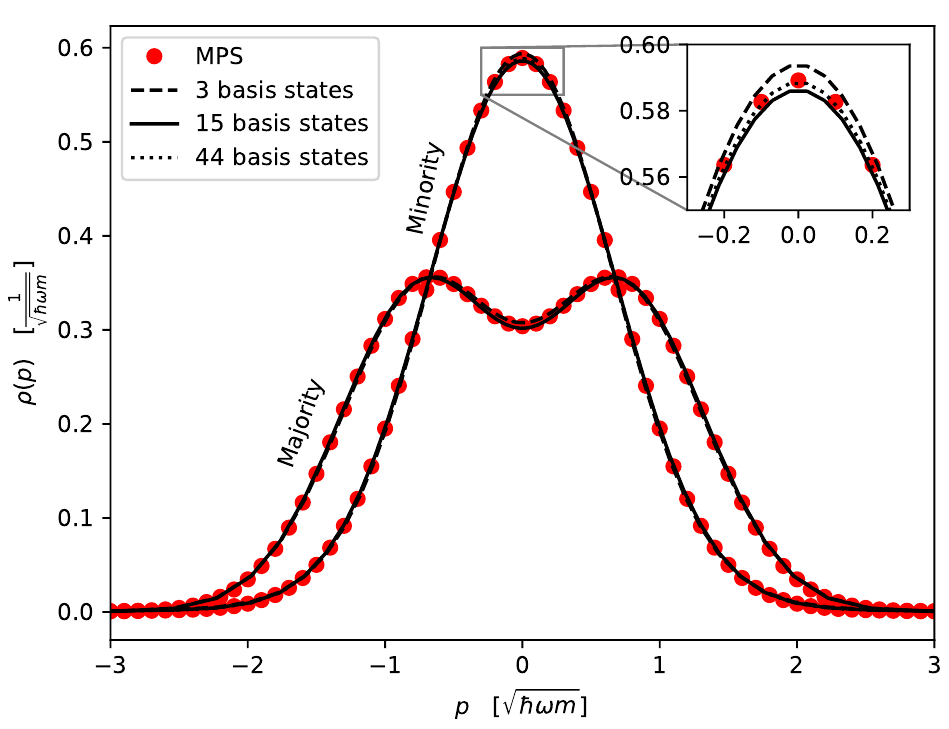
(cid:113) m = 1 for the 2 + ħ h 3 ω